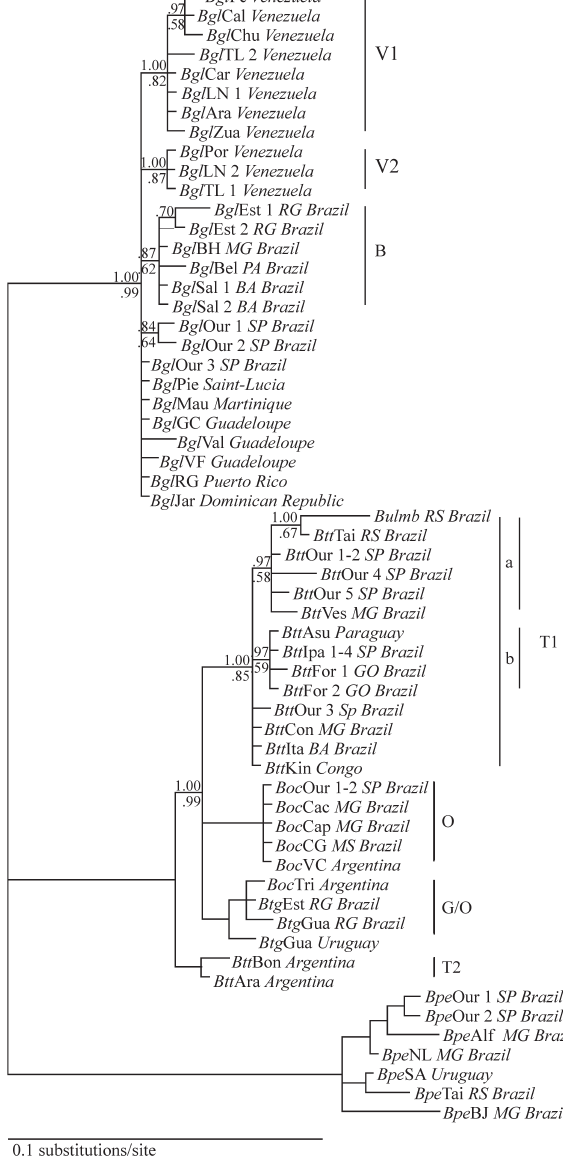
Figure 2 - Bayesian phylogenetic tree for Biomphalaria ITS2 sequences. Values above and below nodes indicate clade posterior probabilities and maximum parsimony (MP) bootstrap proportions,